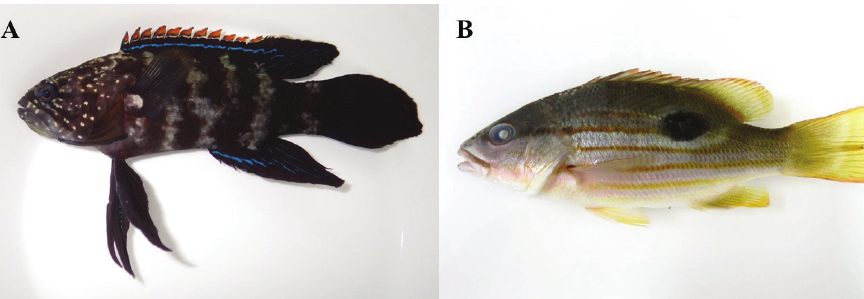
Figure 5. A Vellitor centropomus , MFD-933, 75.6 mm SL B Eumicrotremus uenoi , MFD-932, 17.8 mm SL.